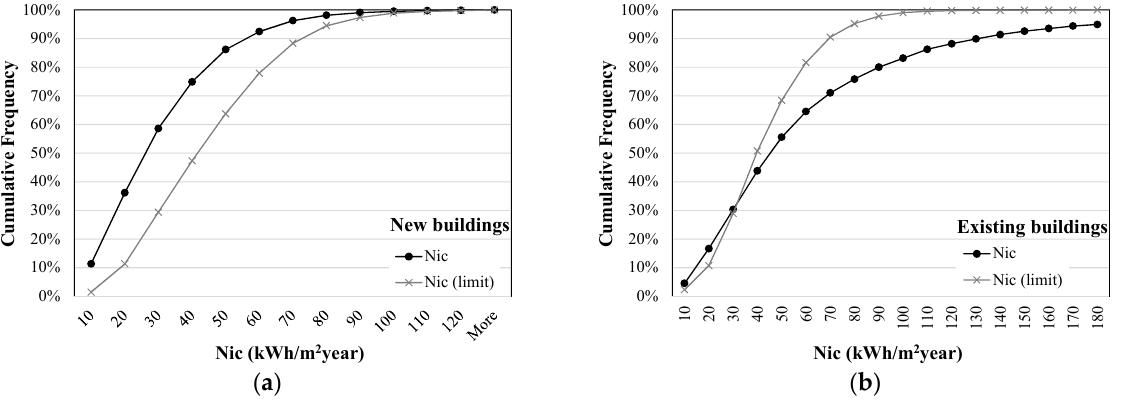
Figure 5. Cumulative frequency of nominal primary energy needs for new buildings ( a ) and existing buildings ( b ) buildings in Portugal [25].